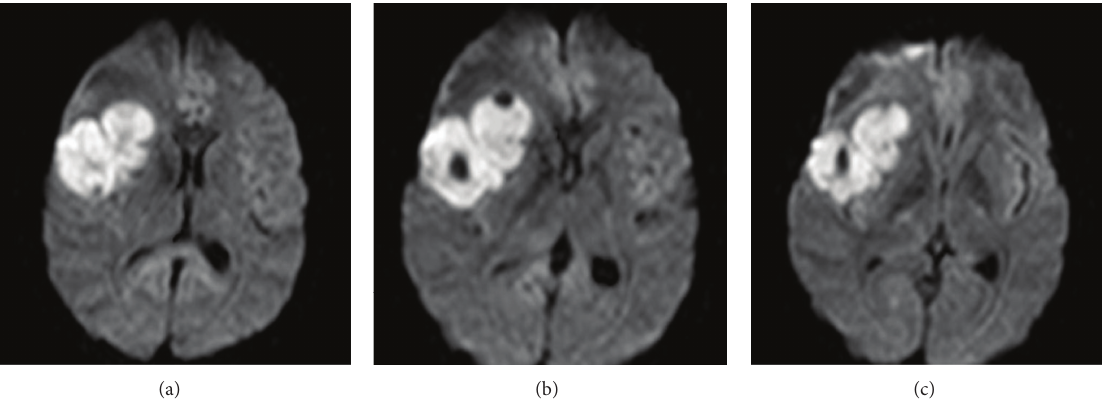
Figure 2: Isotropic diffusion weighted images (DWI) showing signal restriction associated with the fronto-temporal